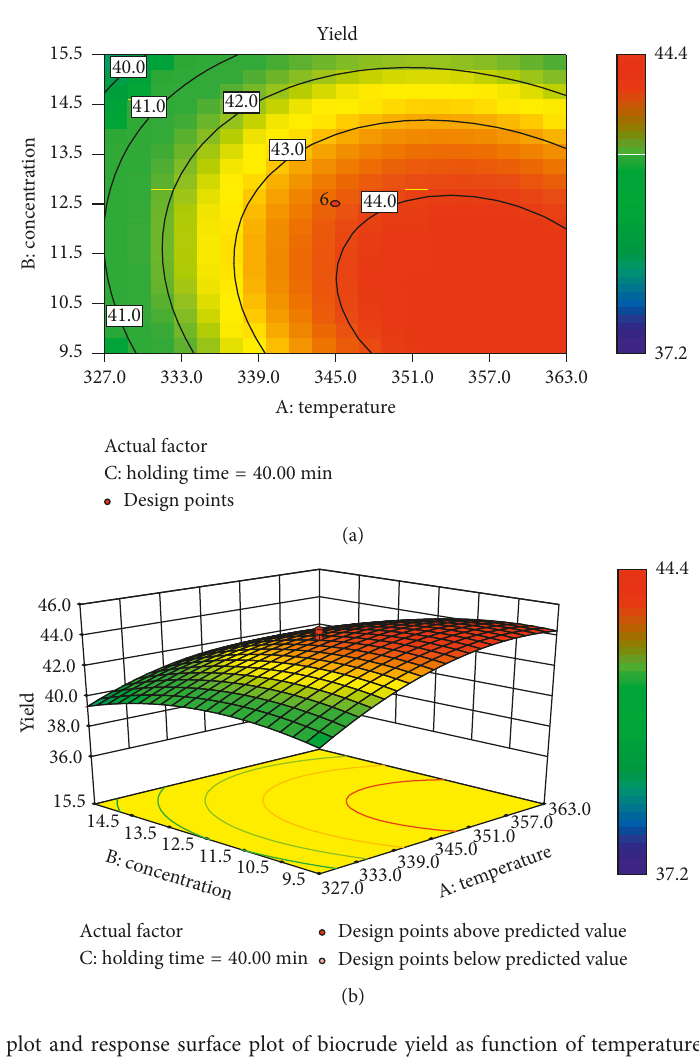
Figure 3: Contour plot and response surface plot of biocrude yield as function of temperature and